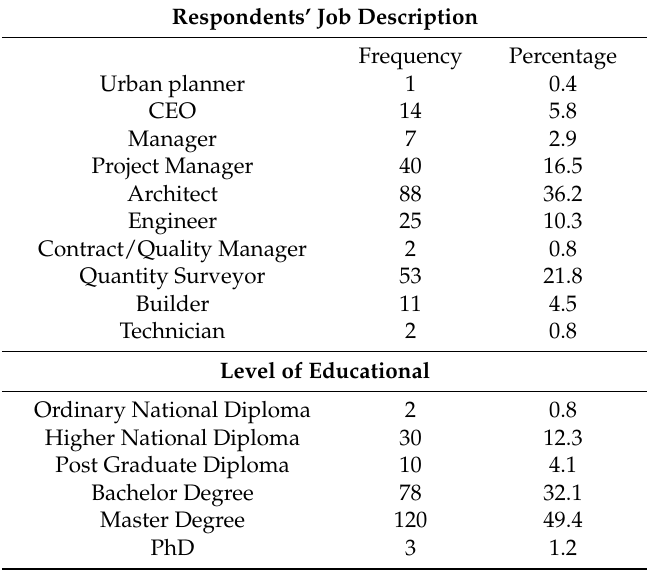
Table 2. Respondents’ profile.